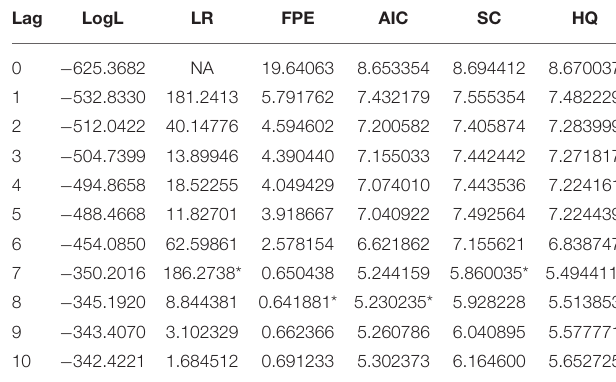
TABLE 3 | Lag length selection